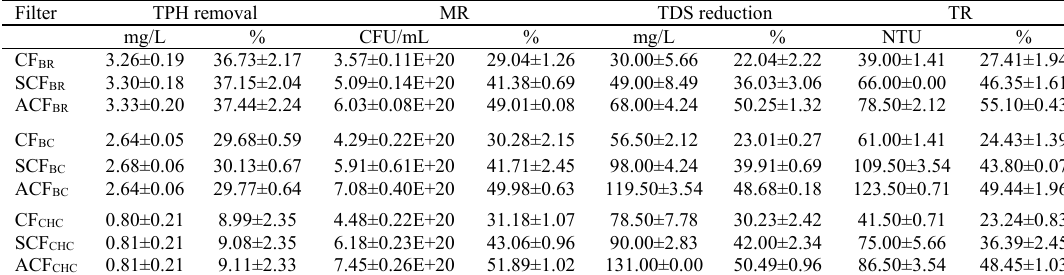
Table 3: Results for media filtration